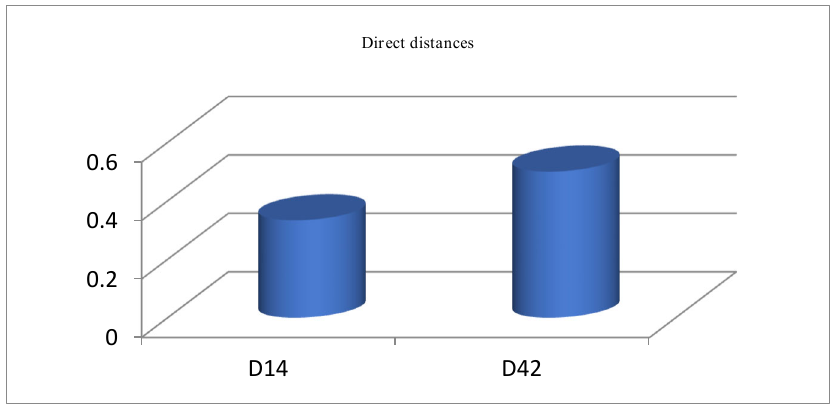
Figure 3. Forward and backward mximum distances.